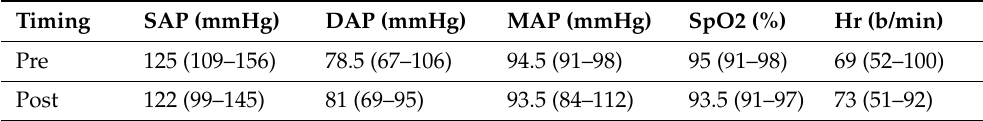
Table 4. No ventricular arrythmias were detected during the procedures. Table 3. Hemodynamics and oxygenation measurements before (pre) and after (post) DEX infusion. Median values (and ranges) are given. Pre = baseline, Post = after